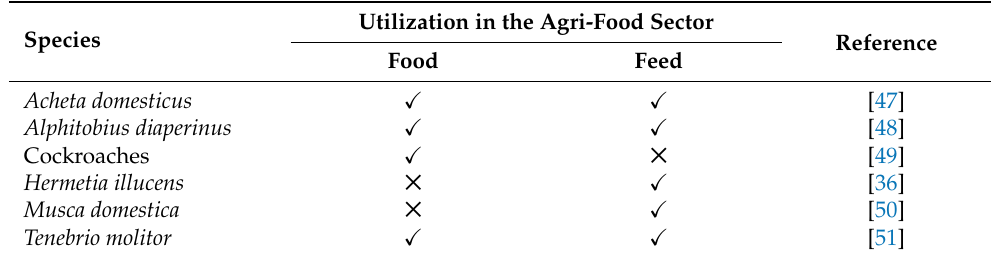
Table 1. Insects capable of converting different waste